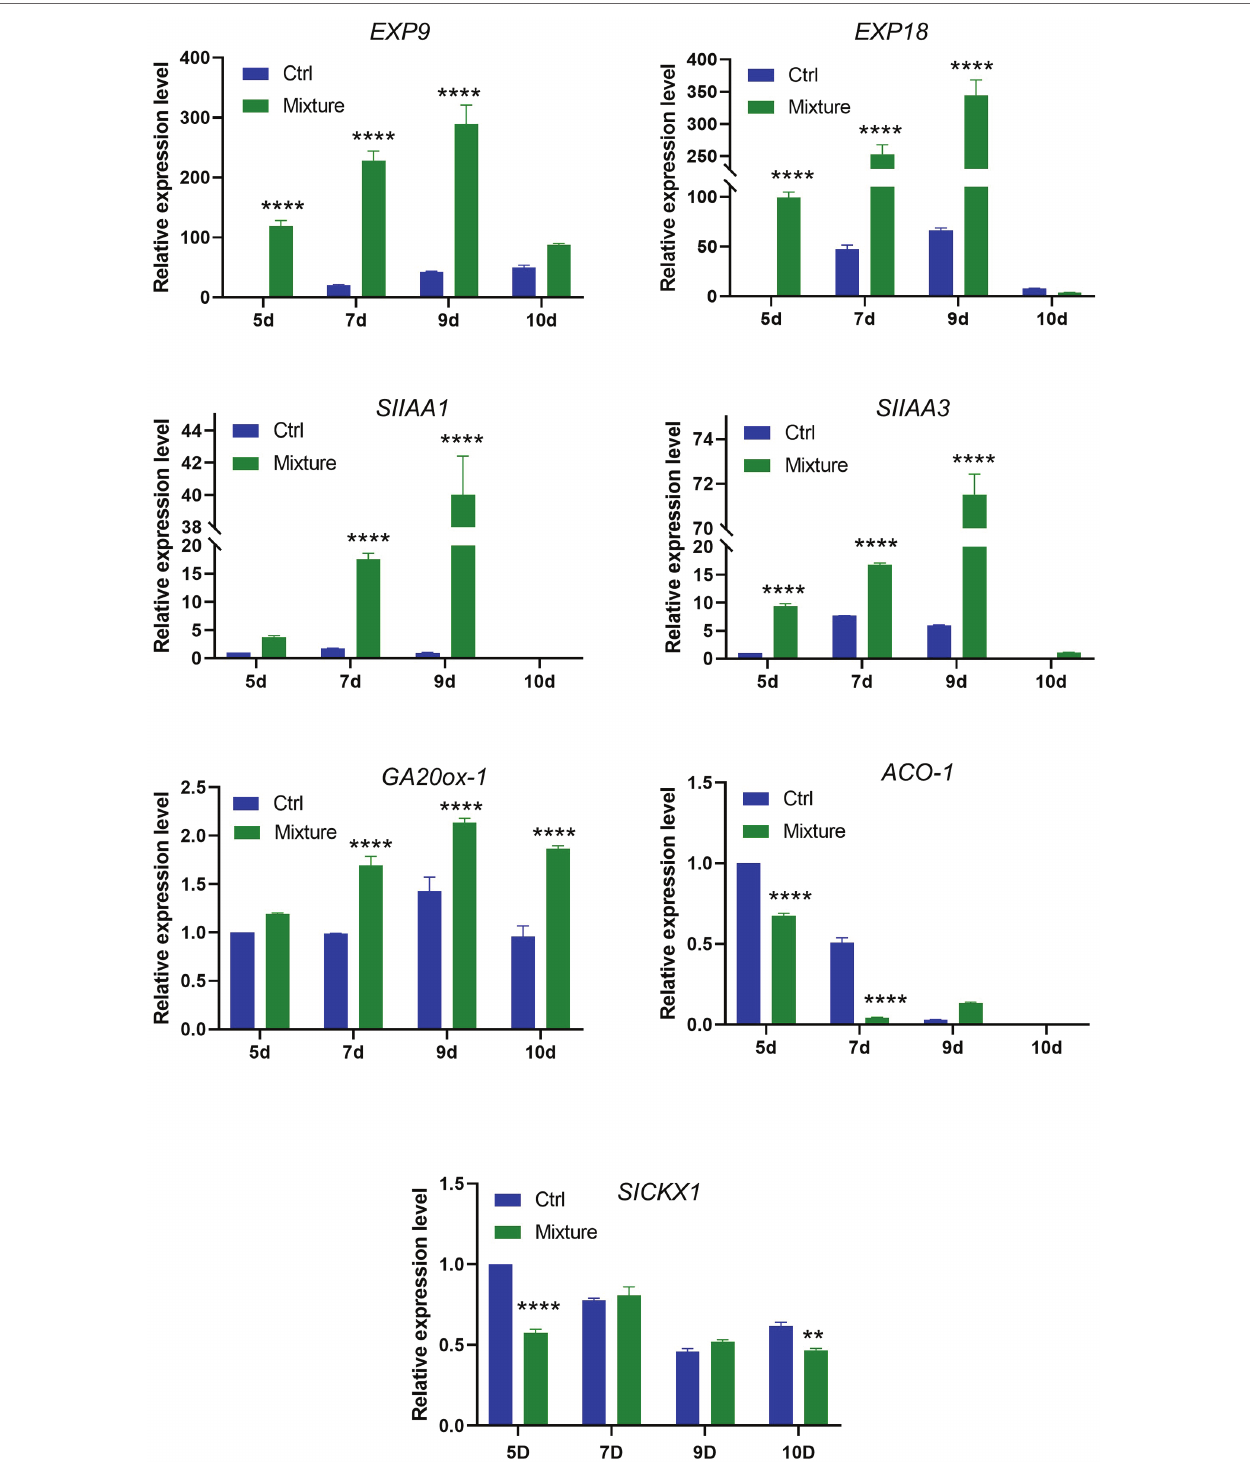
FIGURE 6 | Expression profiles of genes involved in expansin, auxin, cytokinin, and gibberellin synthesis and metabolism following exposure to 2-methyl-butanal and 3-methyl-butanal. Plants were exposed to blends of 2-methyl-butanal and 3-methyl-butanal (1 μ M + 1 μ M) for a time course of 5, 7, 9, and 10 days. qRT-PCR was performed with SYBR and relative expression levels of genes related to expansin ( EXP9 , EXP18 ), auxin ( SIAA1 , SIAA3 ), gibberellin ( GA20ox-1 ), ethylene ( ACO1 ), cytokinin ( SICKX1 ) biosynthesis and metabolism were determined. Asterisks indicate significant difference among no treatment (Ctrl) and exposure to two chemical mixtures (Mixture) in each time (two-way ANOVA, **p < 0.01, and ****p <